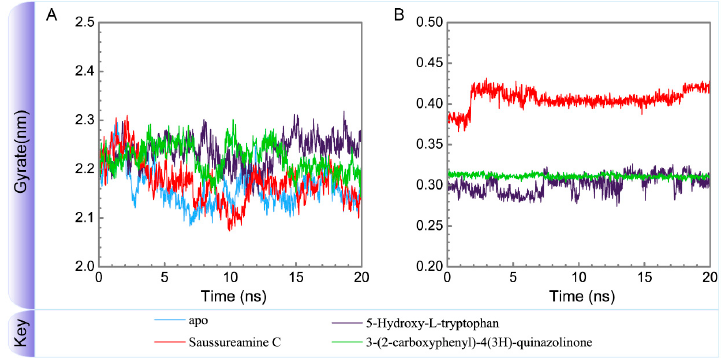
Figure 15. Variation of radii of gyration of ( A ) protein and ( B ) ligand over 20 ns for paraplegin in apo form and in complexes with three TCM candidates.